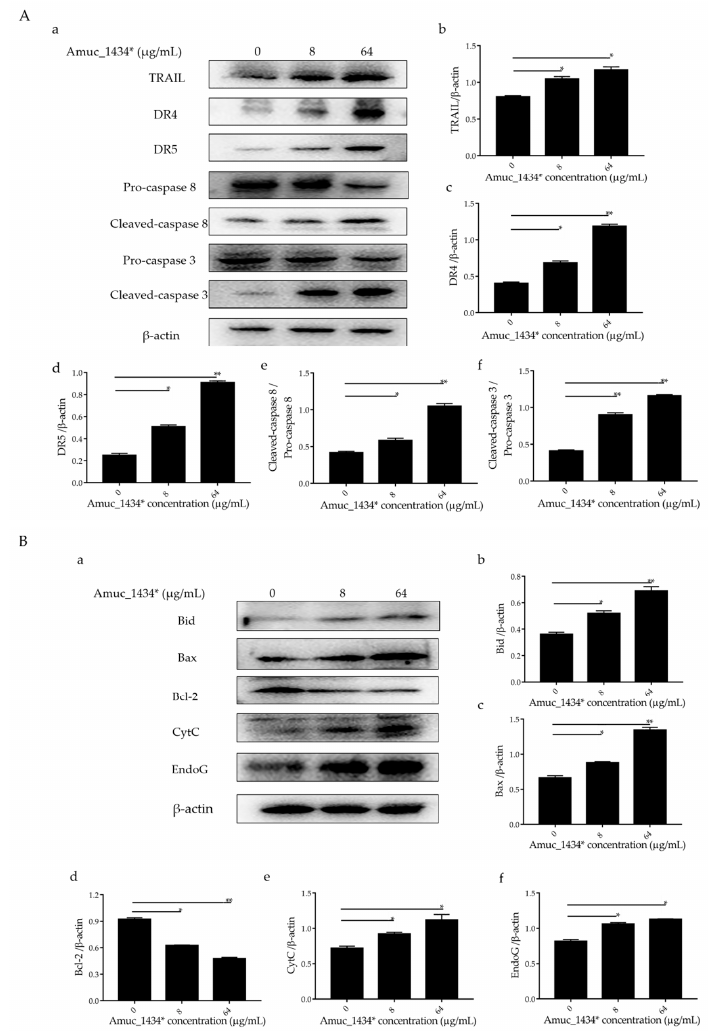
Figure 5. Amuc_1434* mediated the activation of the apoptosis pathway in LS174T cells. ( A ) The expression of death receptor 4 (DR4), death receptor 5 (DR5), cysteinyl aspartate specific proteinase 8 (caspase 8) and cysteinyl aspartate specific proteinase 3 (caspase 3) induced by Amuc_1434* in LS174T cells was dependent on tumor necrosis factor-related apoptosis-inducing ligand (TRAIL). ( a ) LS174T cells were treated with 8 and 64 µ g / mL Amuc_1434* for 24 h, respectively. The cell lysates were analyzed by Western blot. ( b – d ) The quantification of TRAIL, DR4, and DR5 levels relative to that of the internal control ( β -actin). ( e ) The cleaved-caspase 8 / pro-caspase 8 ratio and ( f ) the cleaved-caspase 3 / pro-caspase 3 ratio. (Data are expressed as mean ± standard deviation, n = 3, *: p < 0.05; **: p < 0.01.) ( B ) Amuc_1434* indirectly a ff ected the expression of proteins in the mitochondrial apoptosis pathway. ( a ) B-cell lymphoma-2 interacting-domain death agonist (Bid), B-cell lymphoma-2-Associated X Protein (Bax), B-cell lymphoma-2 (Bcl-2), Cytochrome c (CytC), and Endonuclease G (EndoG) proteins of LS174T cells were detected using Western blot analysis after treatment with Amuc_1434* for 24 h. β -actin was used as the loading control. ( b – f ) The results of the Western blot were analyzed using Image J software. (Data are expressed as mean ± standard deviation, n = 3, *: p < 0.05; **: p <